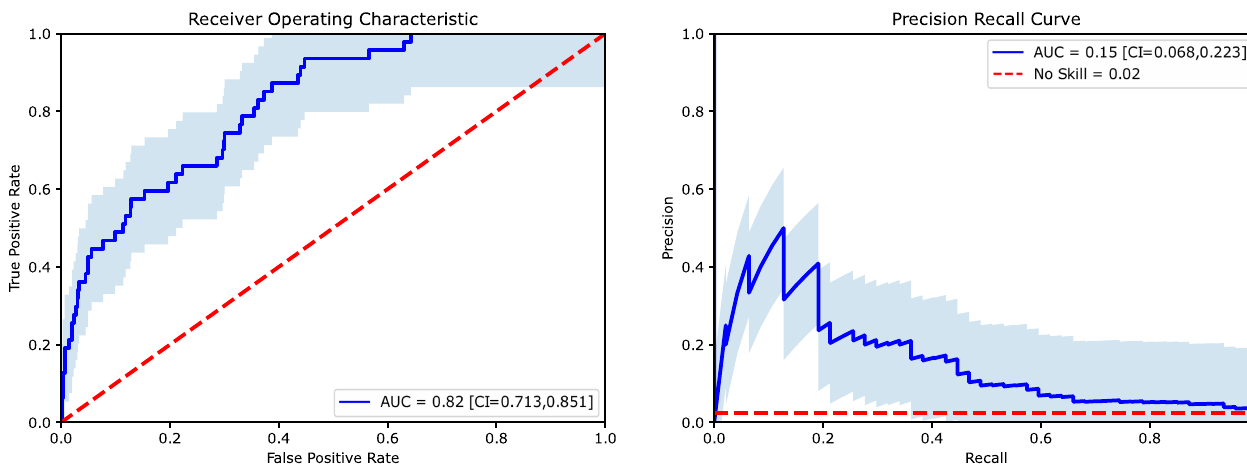
Fig 1. Primary model performance on unseen test data. Receiver Operating Characteristic curve and Precision Recall Curve with confidence bands and computed Area Under the Curve values. Diagonal dashed line shows the curve expected from a no-skill classifier.